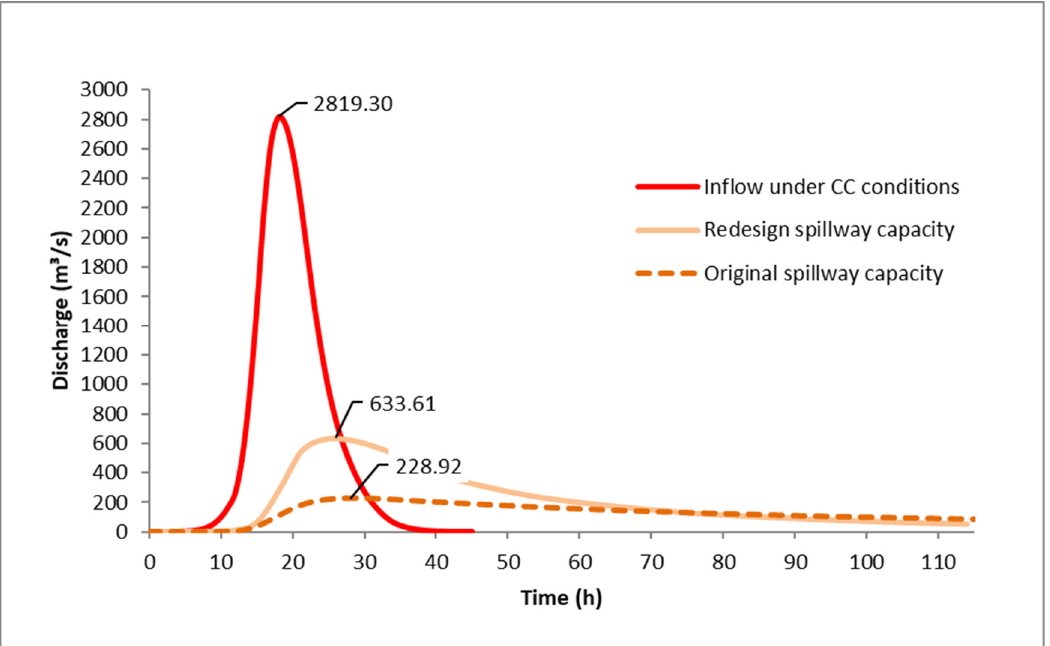
Figure 9. Inflow and outflow hydrographs for the original and redesign excess spillway. Table 4. Comparison of the hydraulic parameters between the original design and the redesign for the Sube y Baja dam.